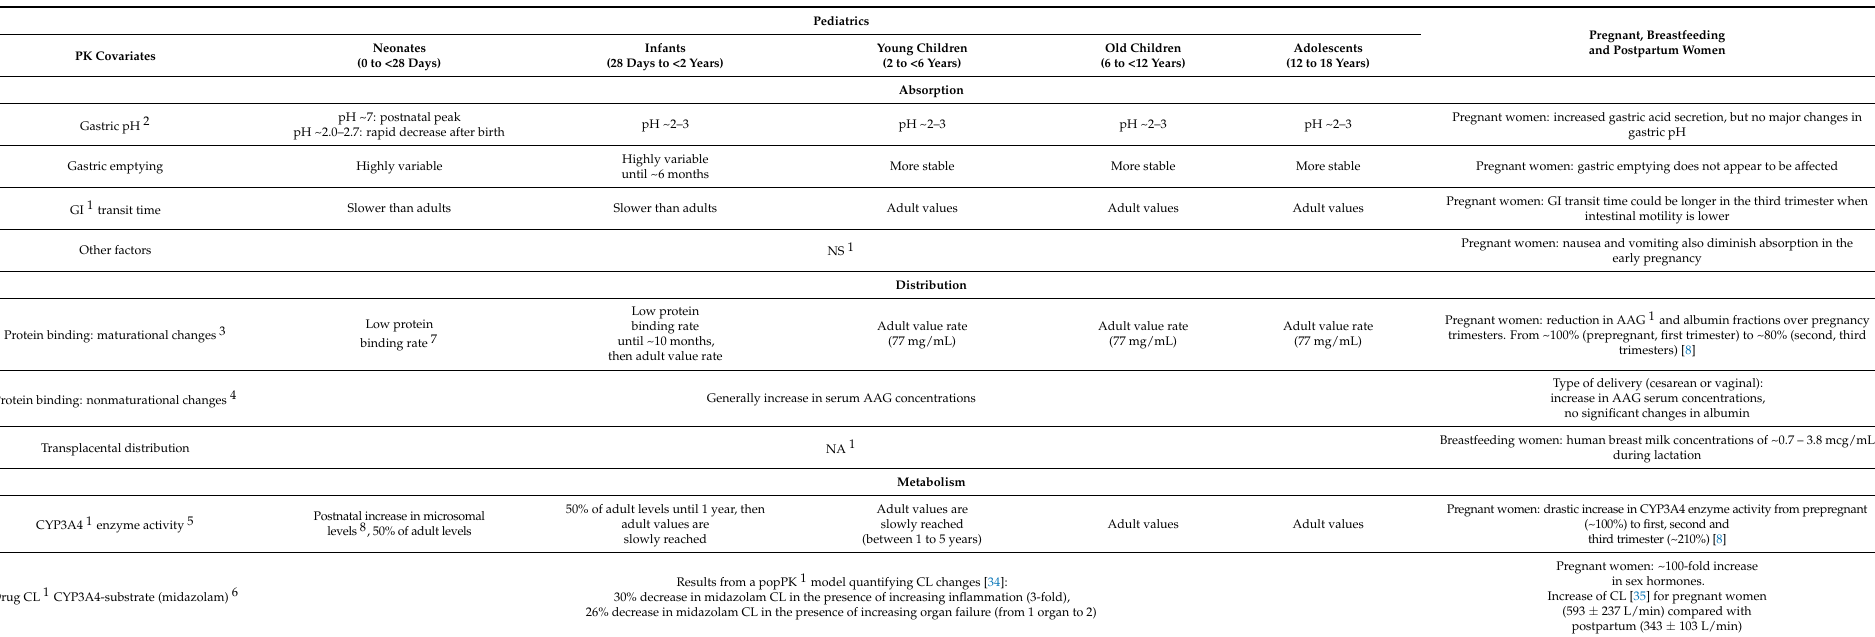
Table 4. Pharmacokinetics in the specified special patient